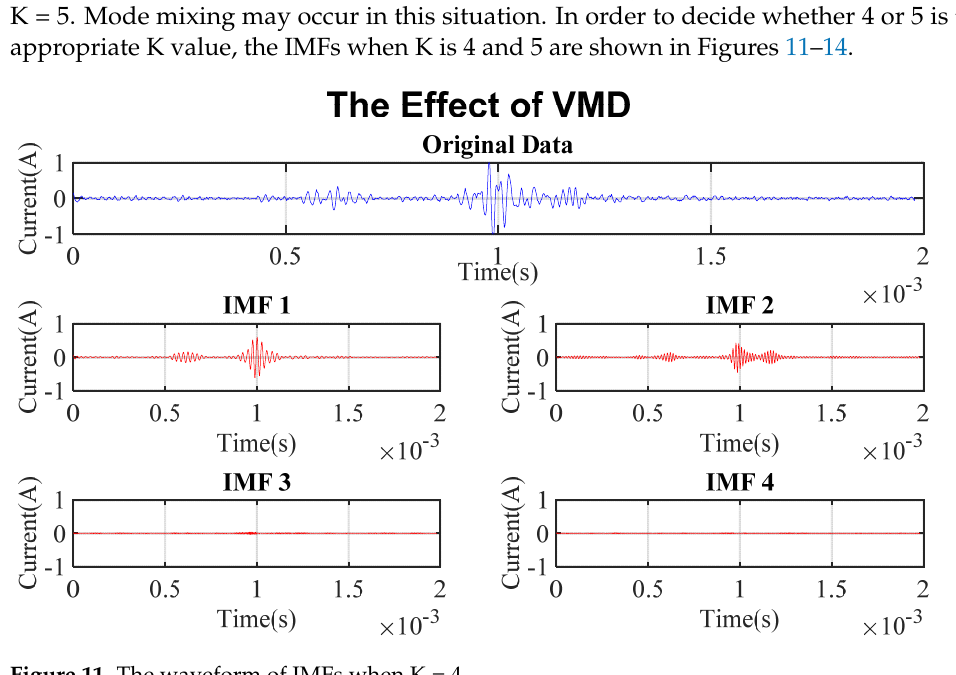
Figure 11. The waveform of IMFs when K = 4.